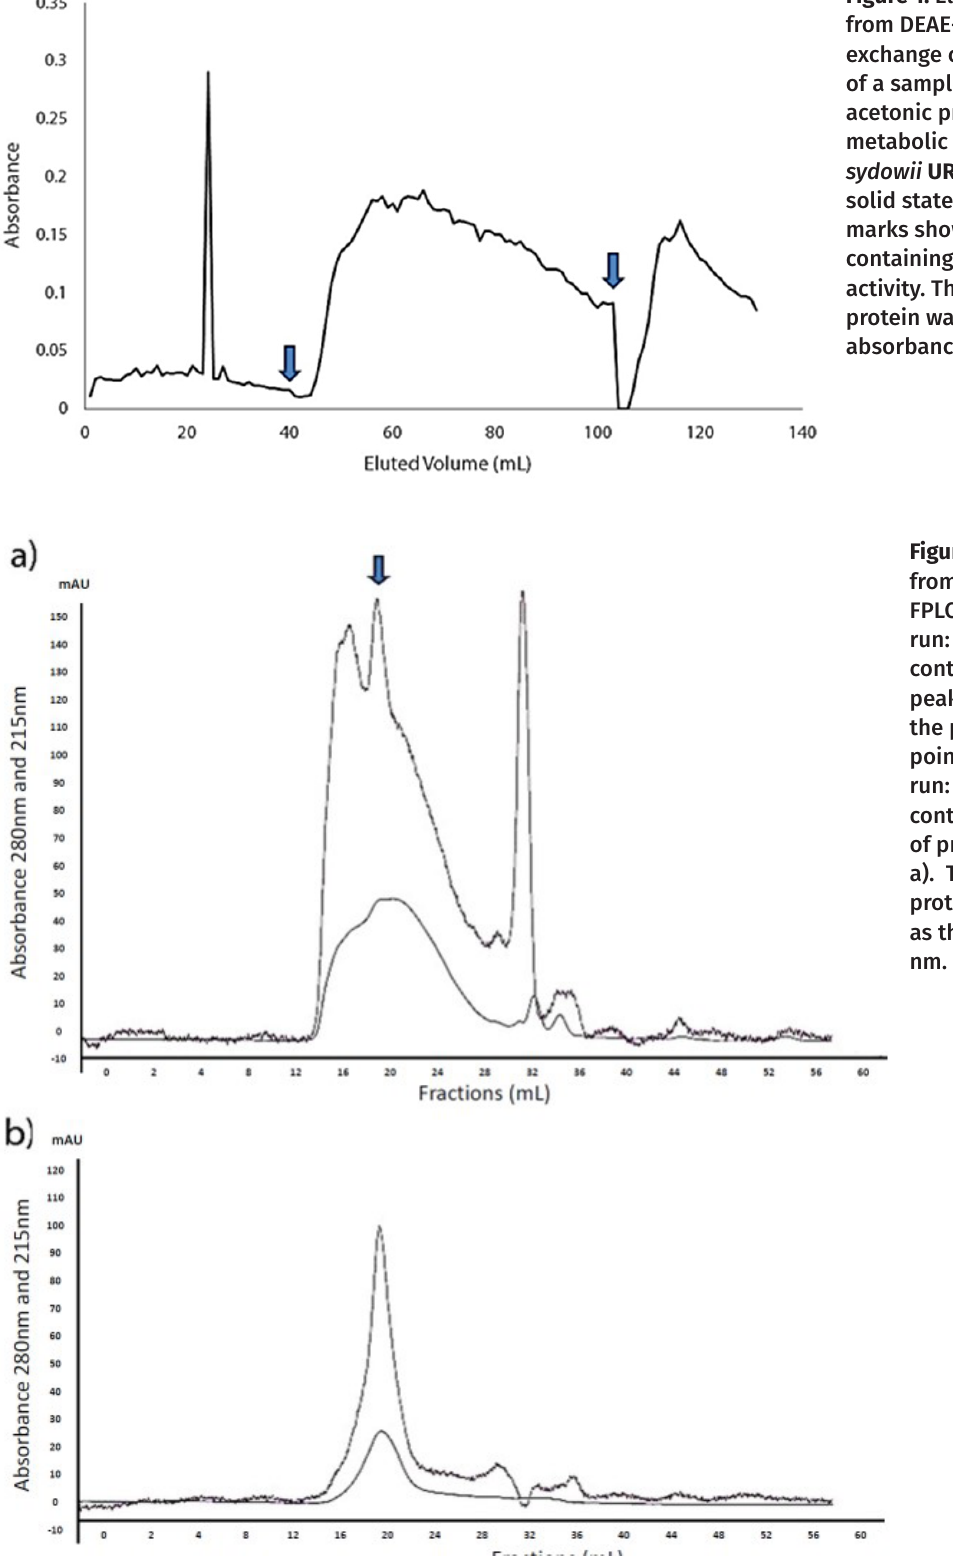
Figure 2. Elution profile from Superdex 75 FPLC system. a) First run: Chromatogram containing varied peaks of protein with the protease peak pointed out. b) Second run: Isolated fraction containing the peak of protease found